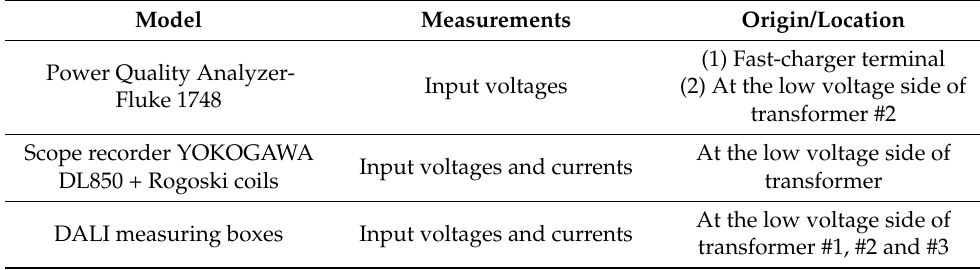
Table 4. Used measurement devices.